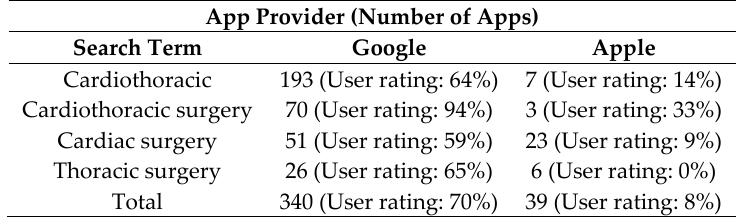
Table 2. Health care category-Apps Comparison of review